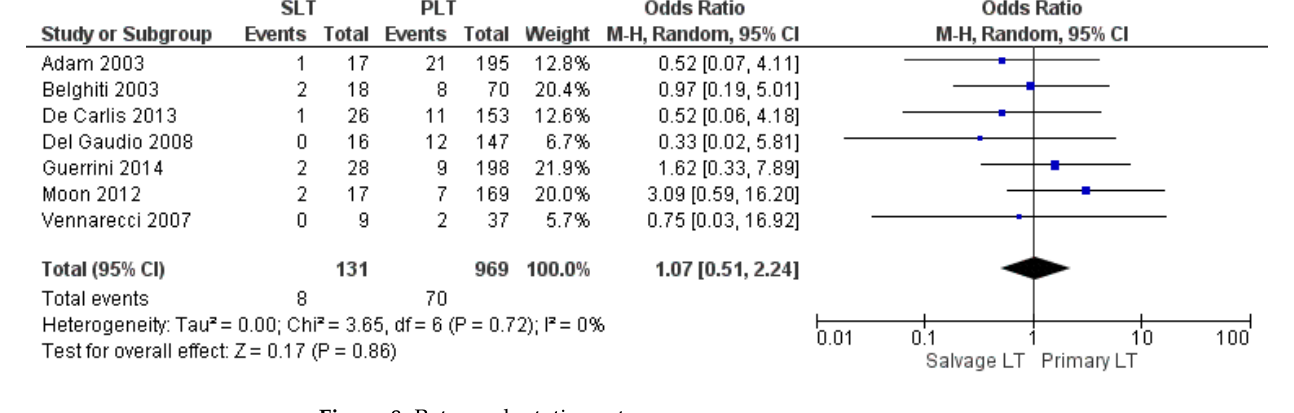
Figure 8. Retransplantation rate.